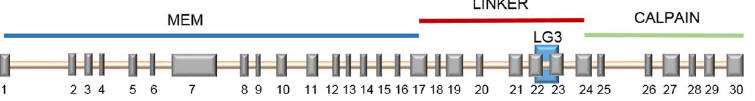
Figure 1. Intron-exon structure of the Physcomitrella patens DEK1 gene. DEK1 ORF consists of 30 exons (grey rectangles) encoding the MEM domain (blue line), the LINKER segment (red line), the LG3 domain (blue rectangle) and the CALPAIN domain (green line). The numbers identify the exons of the DEK1